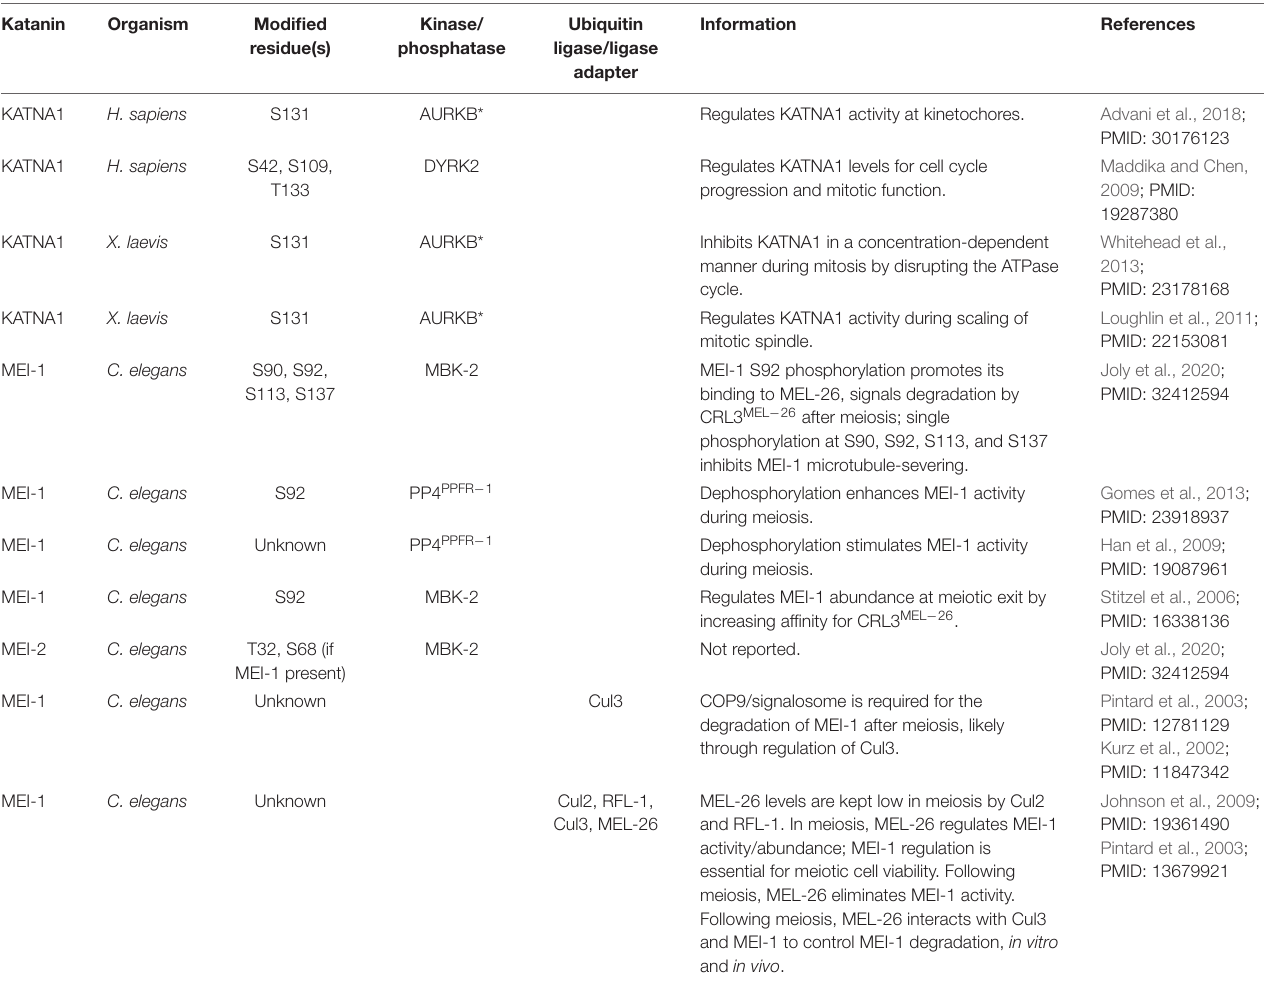
TABLE 2 | Posttranslational regulation of